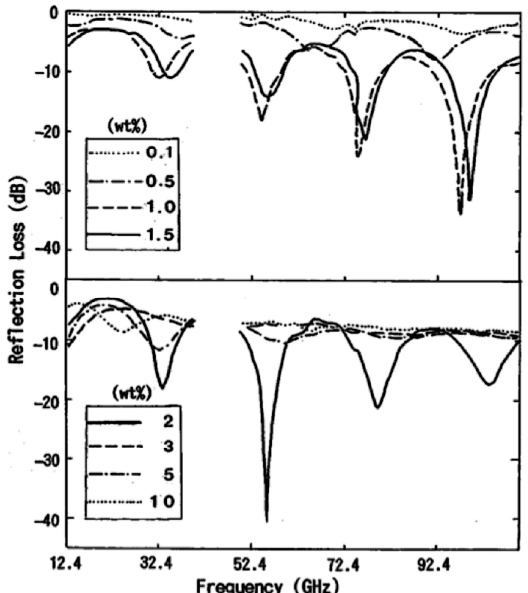
Figure 20. Effect of CMC weight percentage in polyurethane matrix [10]. Reprinted with permission from [10], Copyright 2003 AIP Publishing LLC.